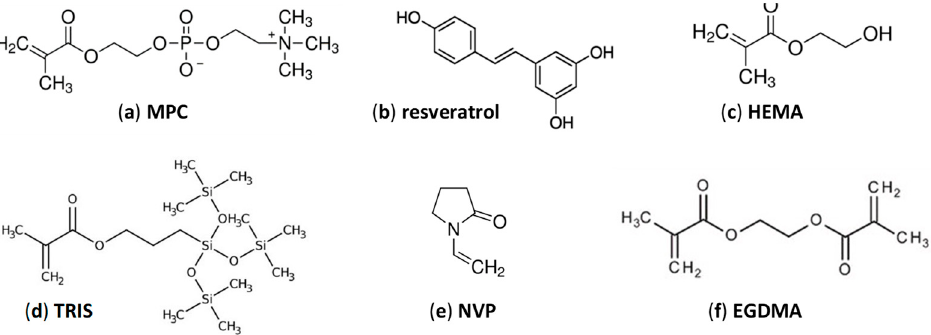
Figure 1. Chemical structure of ( a ) 2-methacryloyloxyethyl phosphorylcholine (MPC), ( b ) trans -resveratrol, ( c ) 2-hydroxyethyl methacrylate (HEMA), ( d ) 3-(methacryloyloxy)propyltris(trimethylsiloxy)silane (TRIS), ( e ) N -vinylpyrrolidone (NVP) and ( f ) ethylene glycol dimethacrylate (EGDMA).